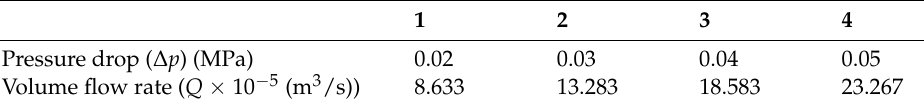
Table 1. The flow measurement data of porous SiC ceramic.